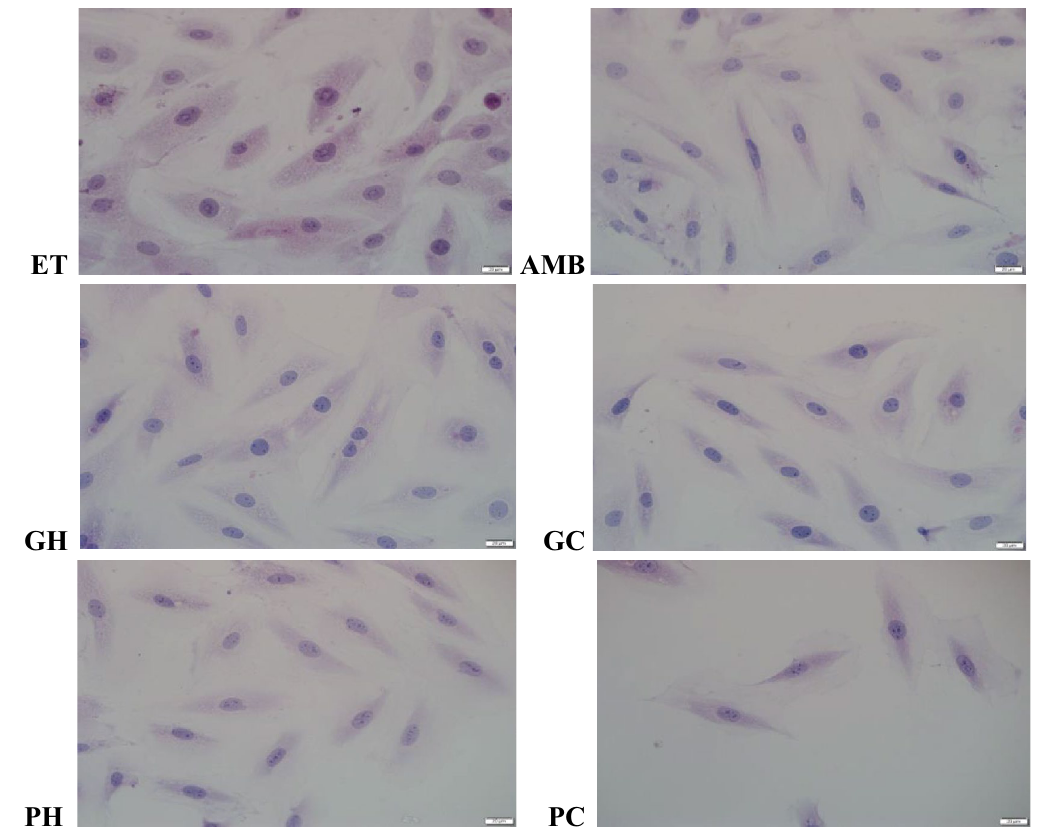
Figure 1. Effects of the hot-water (GH) and cold-water (GC) extracts of P. cubensis and hot-water (PH) and cold-water (PC) extracts of Pan cyanescens mushrooms (50 μg/mL) and positive control ambrisentan (AMB) (25 μg/mL) on the morphology of the cells after 48 h treatment, repeated in three different